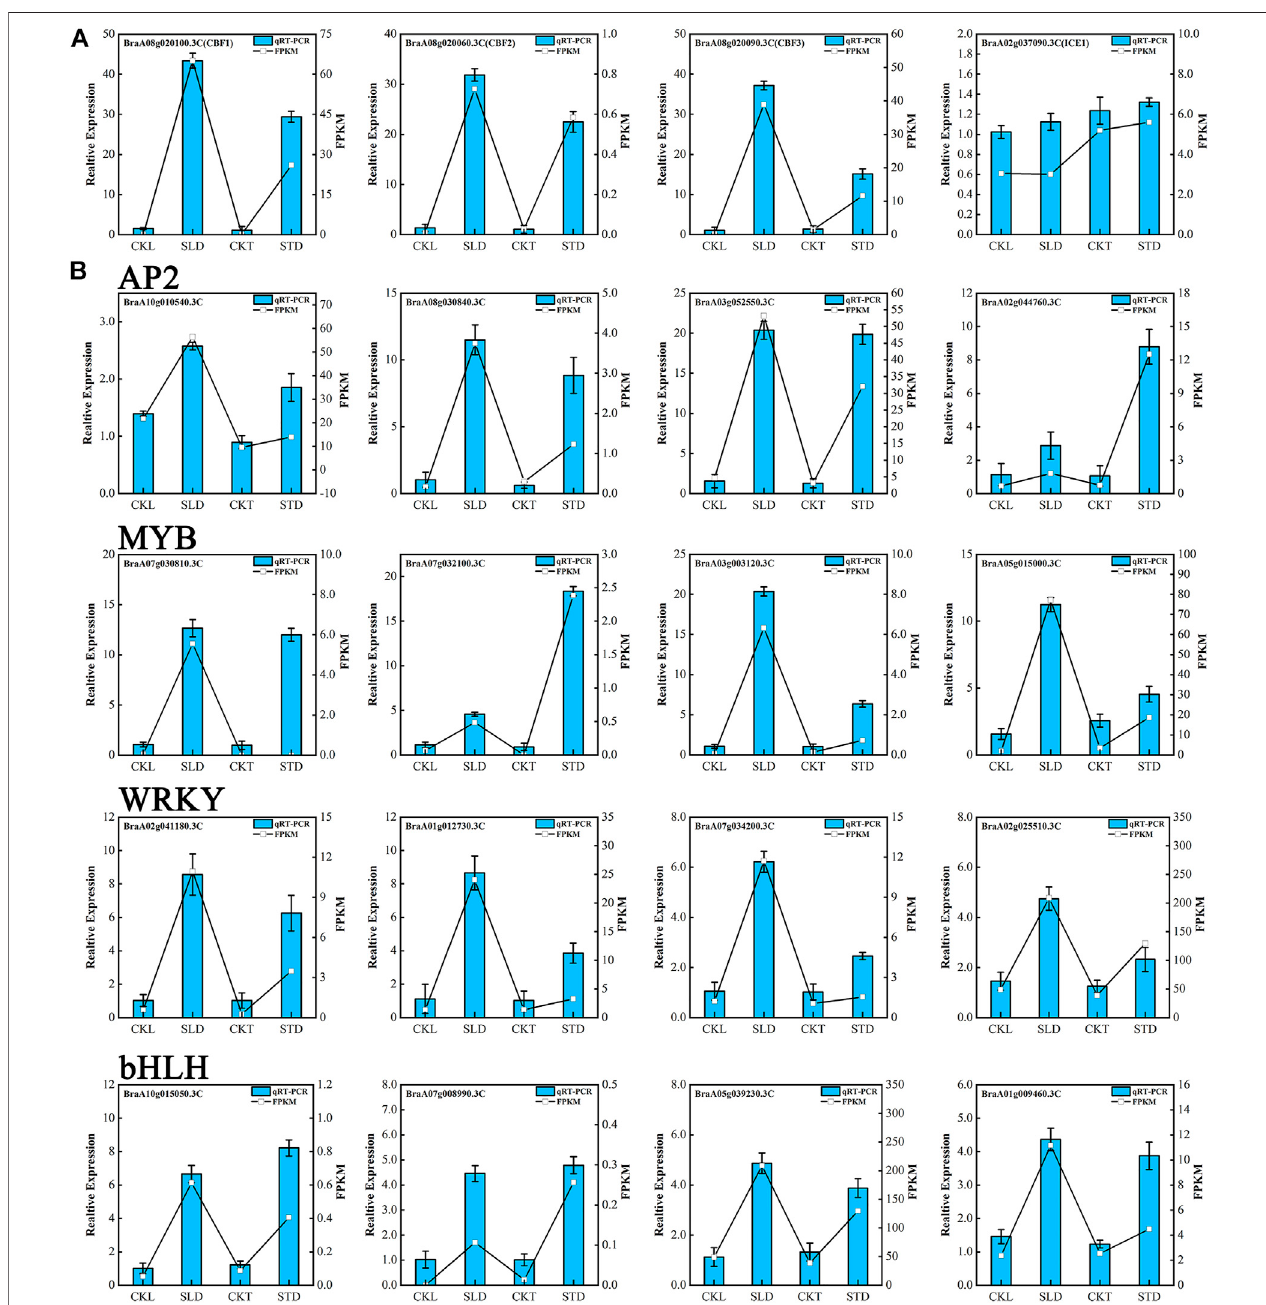
FIGURE 6 | qRT-PCR analysis of cold response genes and transcription factors under freezing stress. (A) Expression of CBFs genes and ICE1. (B) Expression of cold response AP2, MYB, bHLH, and WRKY transcription factors. The relative expression level is indicated on the left y -axis. The FPKM from the RNA-Seq data are indicated on the right y